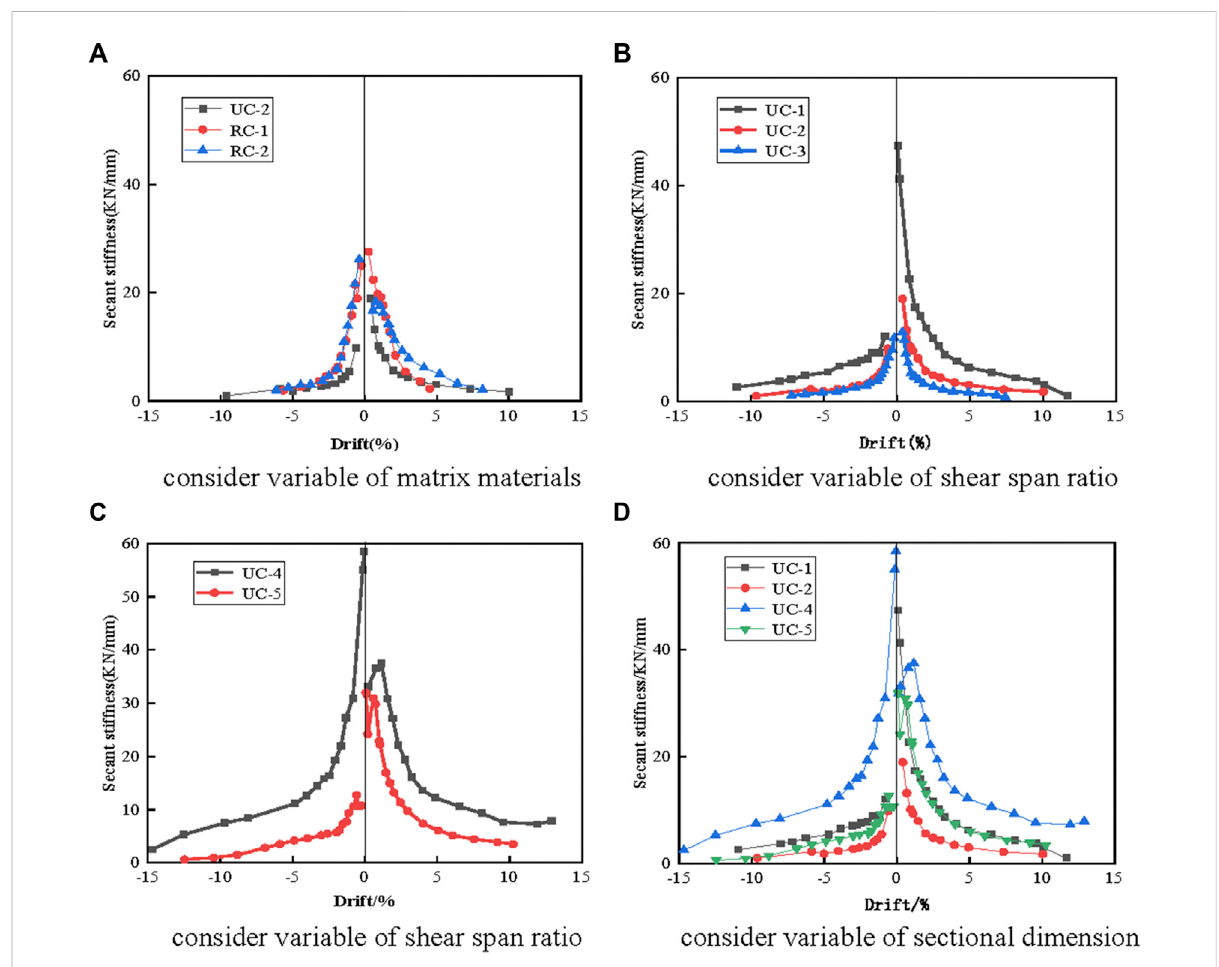
FIGURE 8 Stiffness degradation. (A) Difference induced by introducing ECC. (B) In fl uence of shear span ratio. (C) In fl uence of shear span ratio. (D) In fl uence of sectional